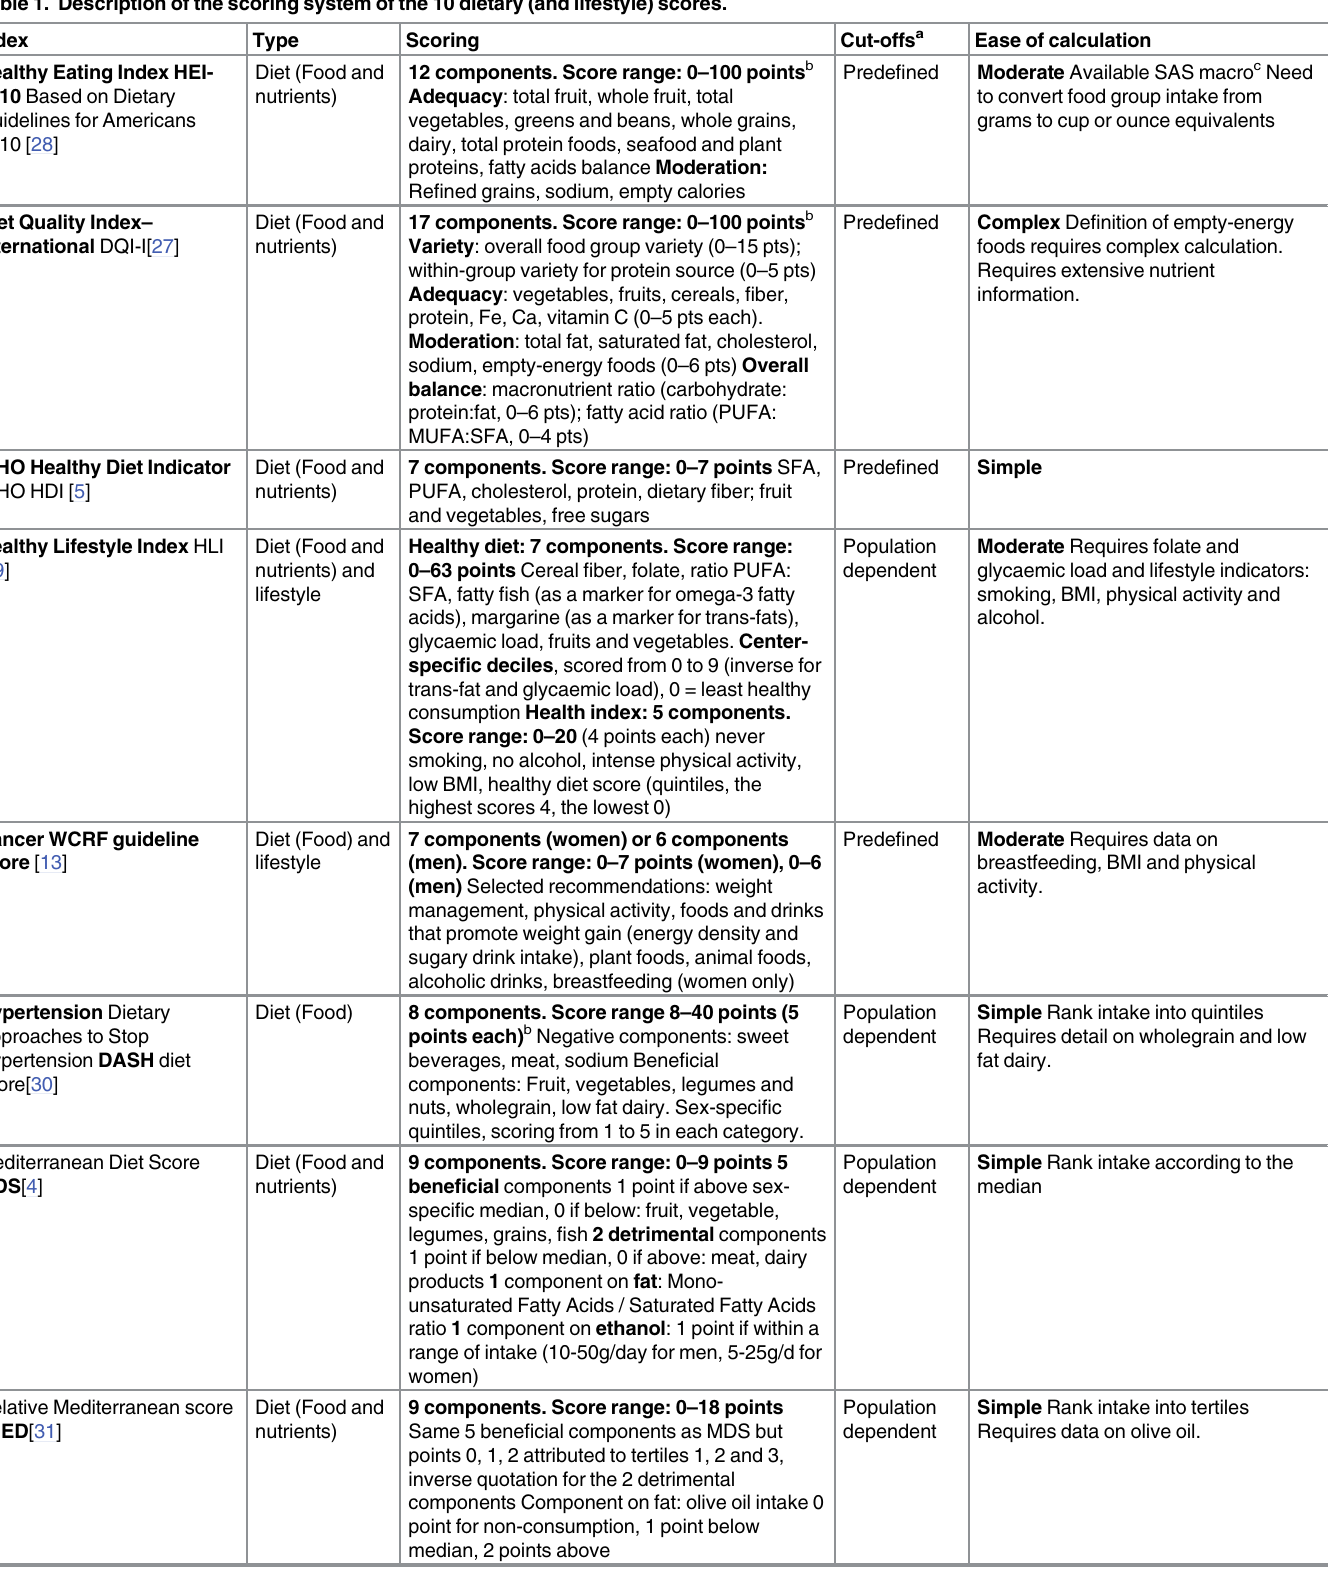
Table 1. Description of the scoring system of the 10 dietary (and lifestyle)